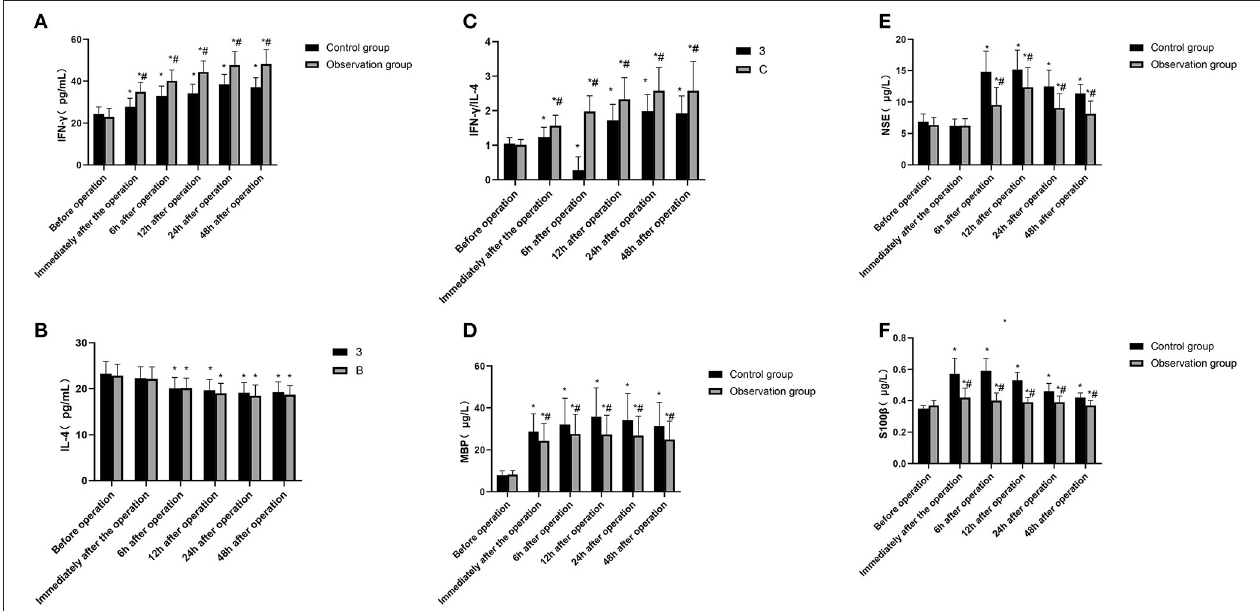
FIGURE 3 | Comparison of IFN- γ , IL-4, IFN- γ /IL-4, neurological impairment related indexes between the two groups of patients at different time points. (A) IFN- γ ; (B) IL-4; (C) IFN- γ /IL-4; (D) MBP; (E) NSE and (F) S100 β . Compared with the preoperative basic value of the same group, * P < 0.05; compared with the control group, # P < 0.05.